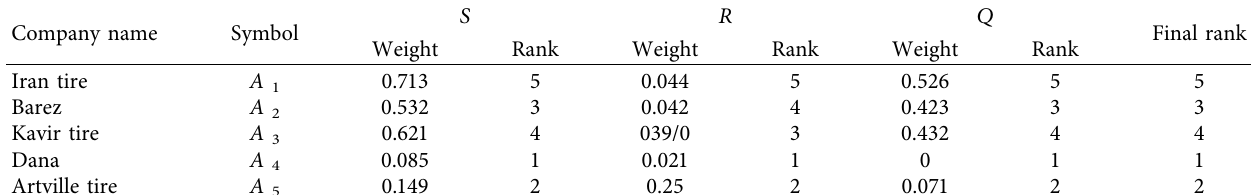
Table 14: The final ranking of options is based on R , S, and Q